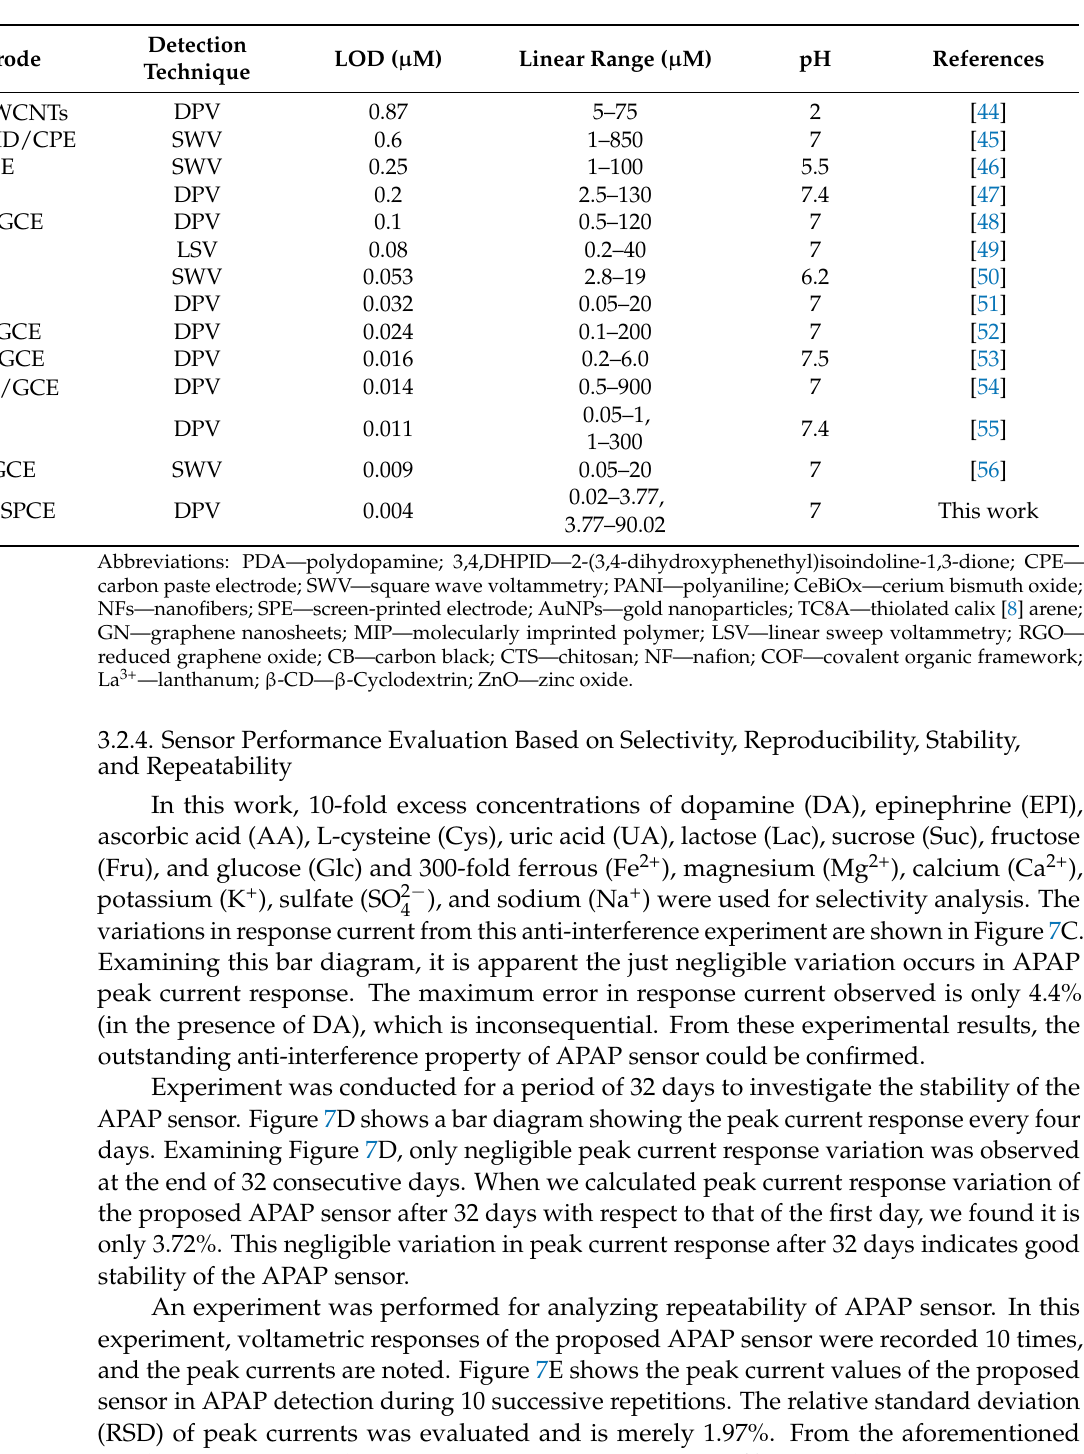
Table 1. Comparative evaluation of AgCuO NPs/fCNTs-based electrode with other modified elec- trodes toward APAP